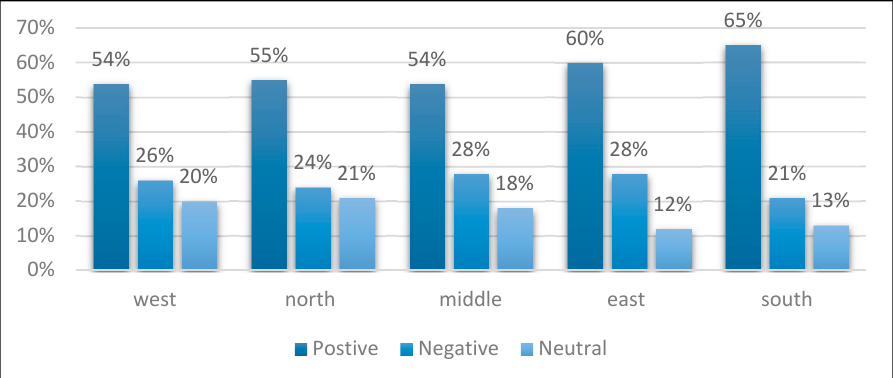
Figure 2. The accuracy using N-gram methods (unigram, unigram TF-IDF, bigram, bigram TF- north region with 55% positive tweets. IDF) with the classifiers (SVM, NB, KNN).